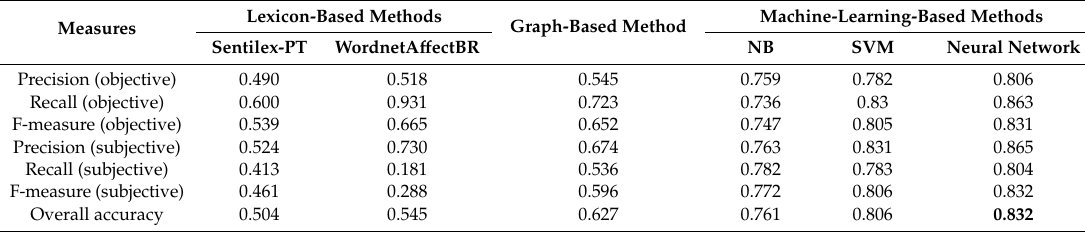
Table 5. Results obtained for the corpus of book reviews in Belis á rio et al.